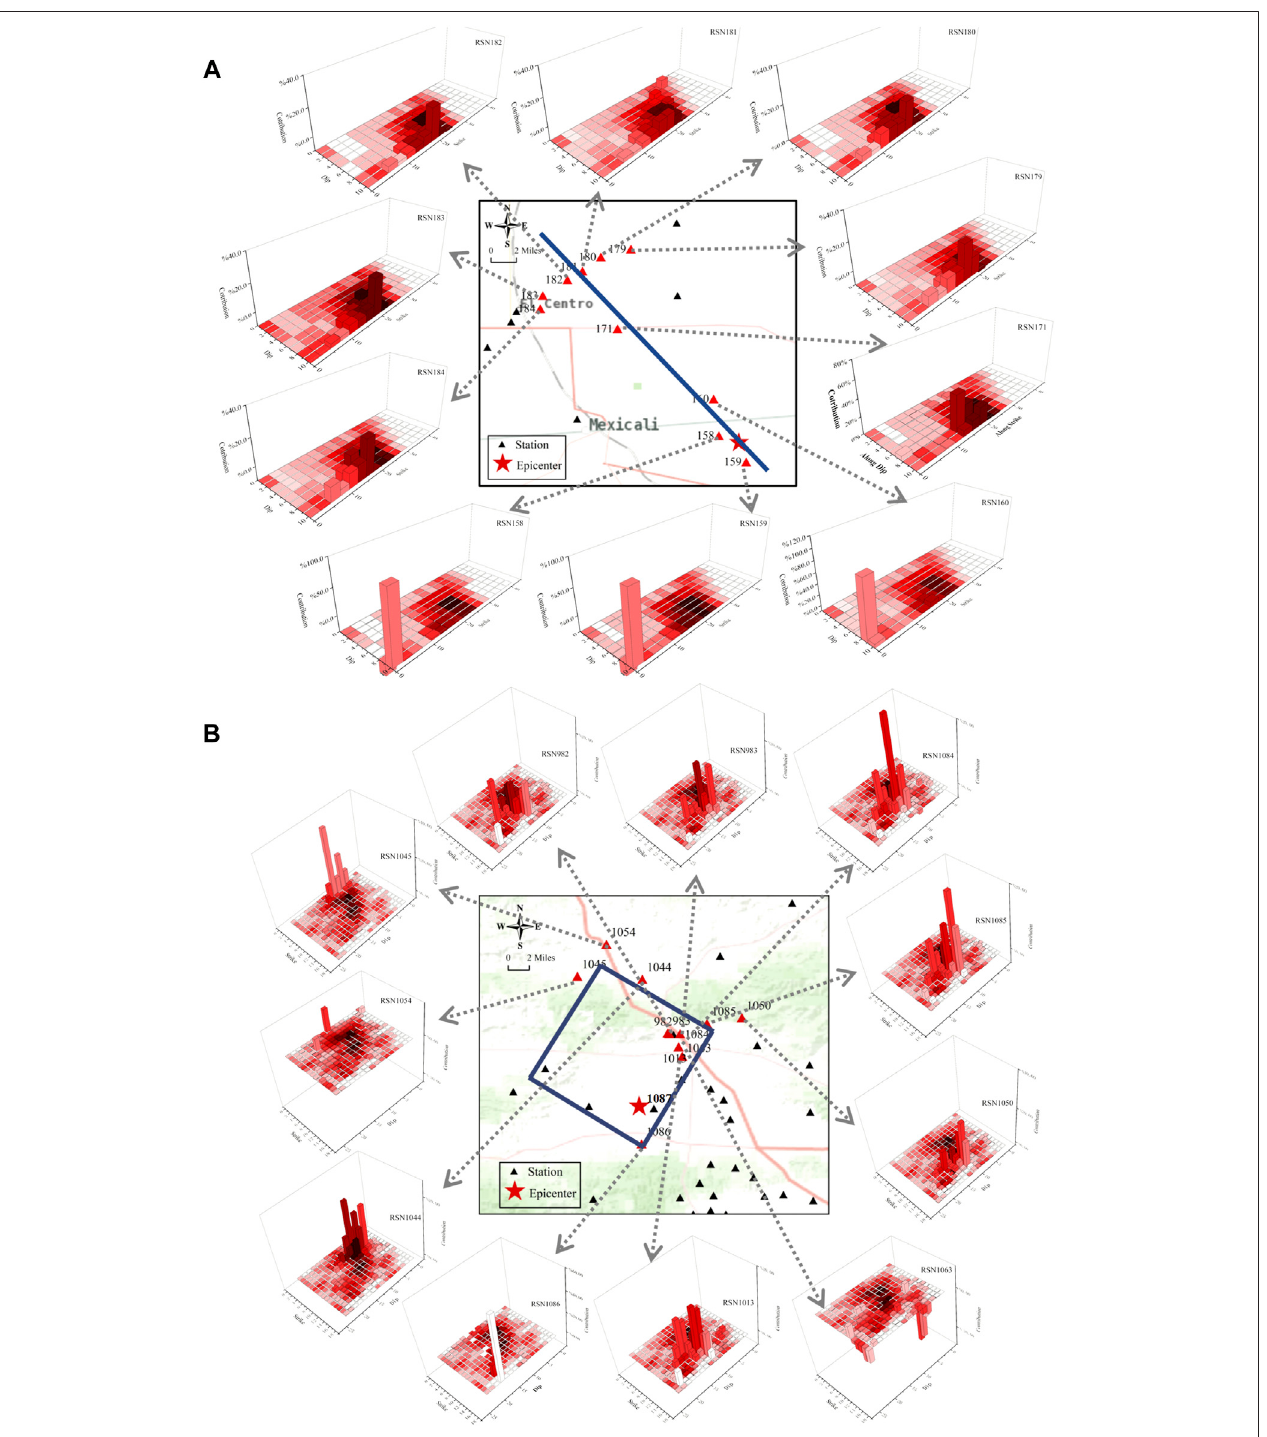
FIGURE7| Contributionsofthevarious sub-faultmotionstothepulse amplitude inthe fi naltimeseries of (A) theImperialValleyEarthquakeand (B) theNorthridge Earthquake.